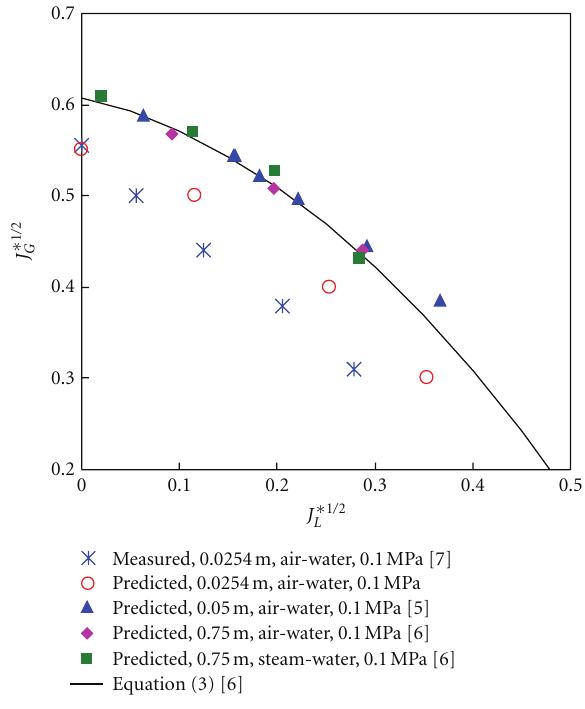
Figure 5: Predicted CCFL characteristics.